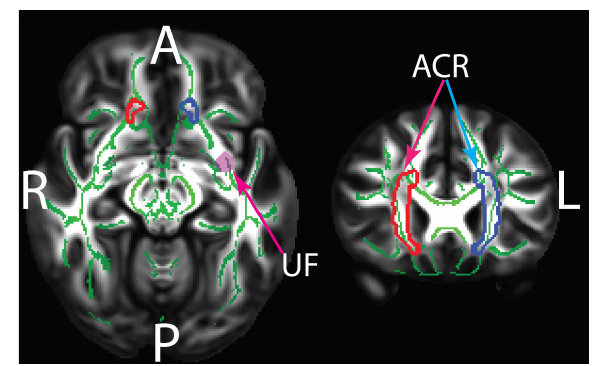
FIGURE 2 | The JHU white matter regions showing statistically significant group differences between old and young adults. ACR, anterior corona radiata; UF, uncinate fasciculus. The underlay shows the TBSS white matter skeleton which was masked by the JHU regions in the statistical analyses. The TBSS skeleton and the JHU regions are overlaid on the HCP 1065 FA template. Green: White matter skeleton; Red: right ACR; Blue: left ACR; pink: left